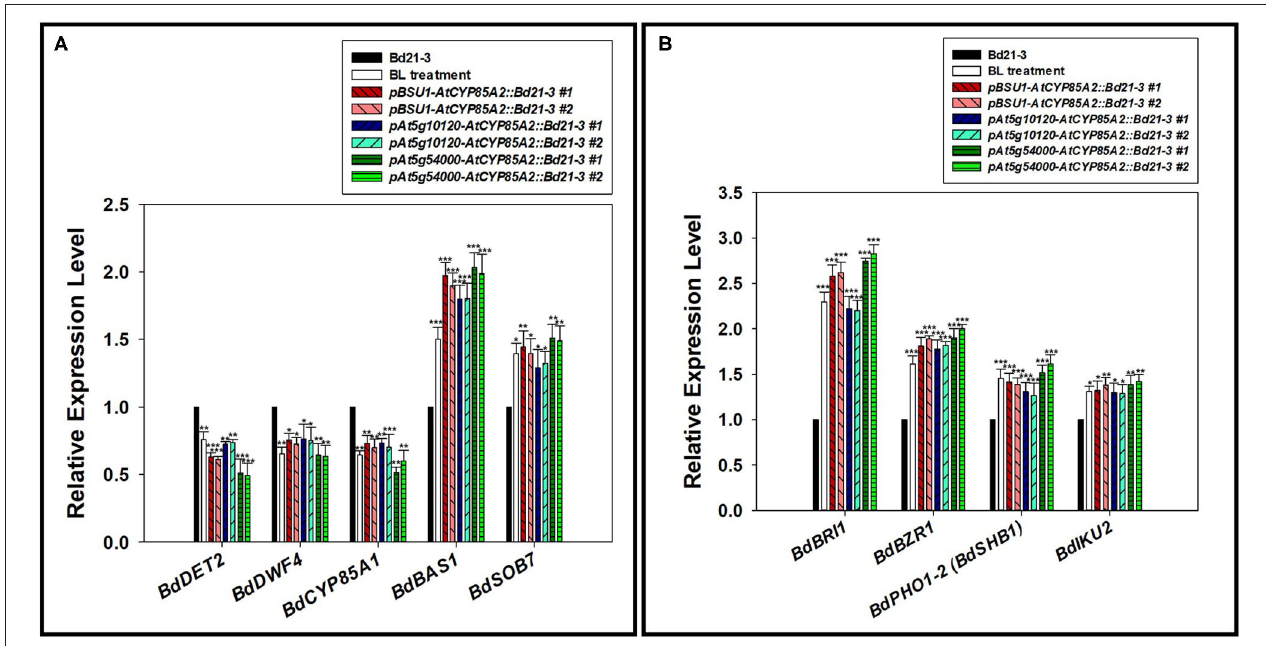
FIGURE 5 | Expression of BR related and seed size determination genes in transgenic Brachypodium mutants. (A) Semi-qPCR of BR metabolic genes. BdDET2(Bradi2g55110) , BdDWF4(Bradi1g69040) , and BdCYP85A1(Bradi1g15030) for BR biosynthesis. BdBAS1(Bradi2g04660) and BdSOB7(Bradi2g44140) for BR catabolism. (B) Semi-qPCR of BR signaling and seed size-determining genes. BdBRI1(Bradi2g48280) and BdBZR1(Bradi1g23550) for BR signaling. BdPHO1-2 (BdSHB1, Bradi3g54920) and BdIKU2(Bradi4g11740) for seed size determination. #1 and #2 represent two different lines for three transgenic plants. Semi-qRT-PCR was performed with total RNA. BdGAPDH was used to normalize the expression level. Two biological repeats along with three technical repeats were performed for quantification of gene expression level. The asterisks indicate the statistical significance of the Student’s t -test: * ( P < 0.05), ** ( P < 0.01), and *** ( P <